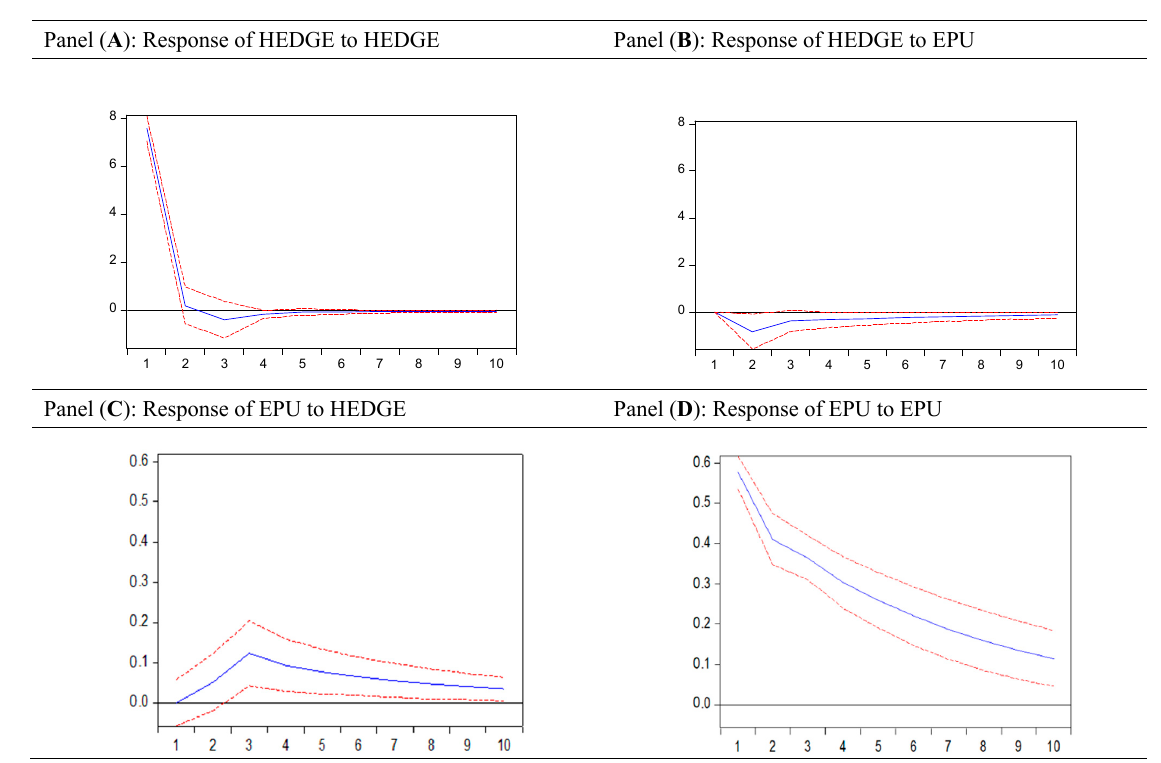
Figure 2. Impulse response function graphs. The figure displays the impulse response of EPU (hedge) on EPU (hedge) and hedge (EPU) across the four panels. Cholesky Ordering is utilized to obtain the results.